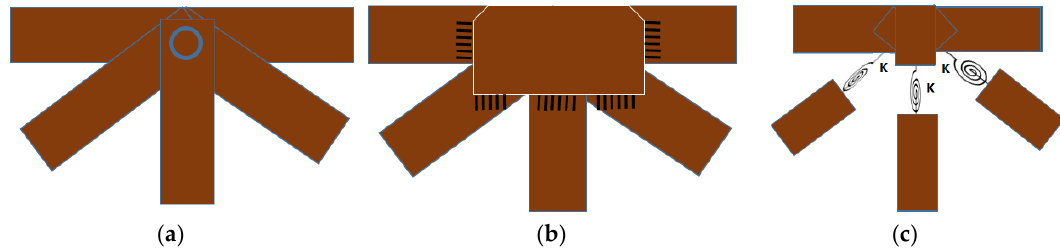
Figure 13. Connection types of truss joints: ( a ) Pin connection; ( b ) Rigid connection; ( c ) Semi-rigid connection (rotational springs).